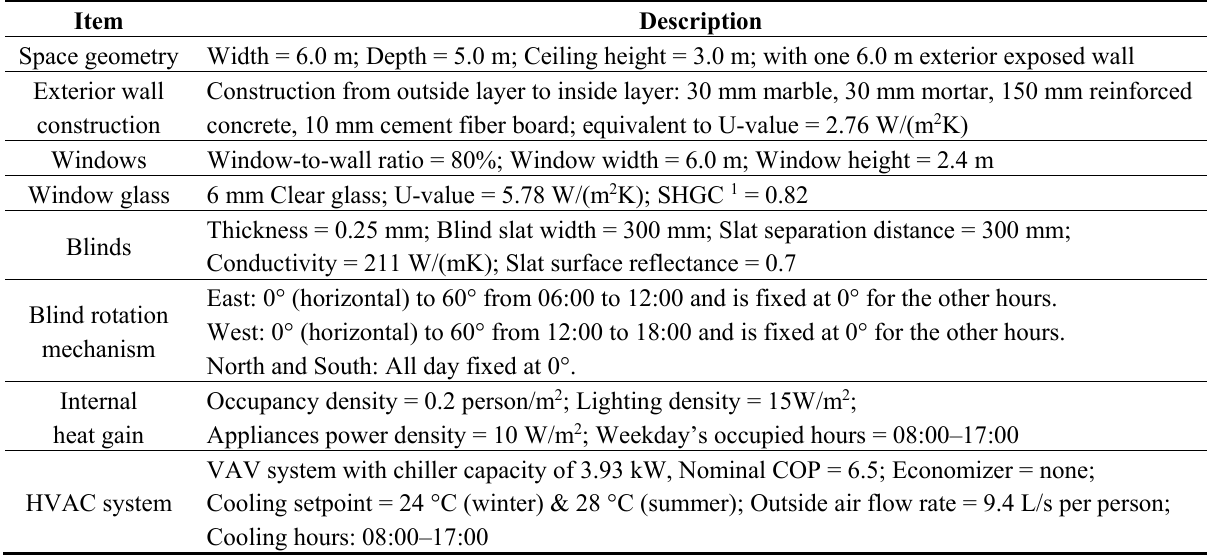
Figure 9. Climatic conditions of Taipei and Kaohsiung ( a ) outdoor temperature with annual cooling degree days ( b ) global solar radiation. Table 2. Description of the simulated